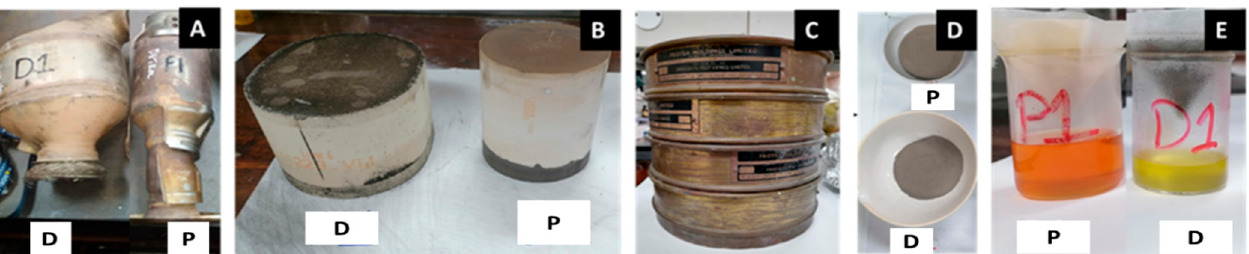
Figure 2. Dismantling and leaching process of diesel (D) and petrol (P) spent catalytic converters where ( A ) spent catalytic converters for diesel (D) and petrol (P), ( B ) dismantled catalytic converters, ( C ) Sieving tool used to mesh crushed catalytic converter, ( D ) meshed to up 85 µm particles and ( E ) leached D and P sample using 3:1 HCl: NHO 3.